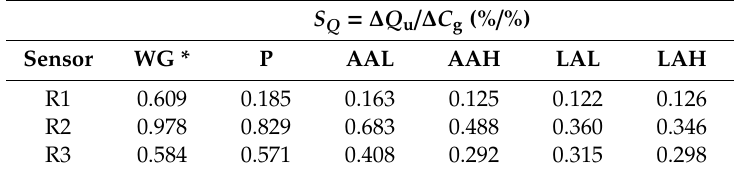
Table 2. Sensitivities of the sensors for all sets regarding Q u . * Data from [43]. WG: water–glucose solution.